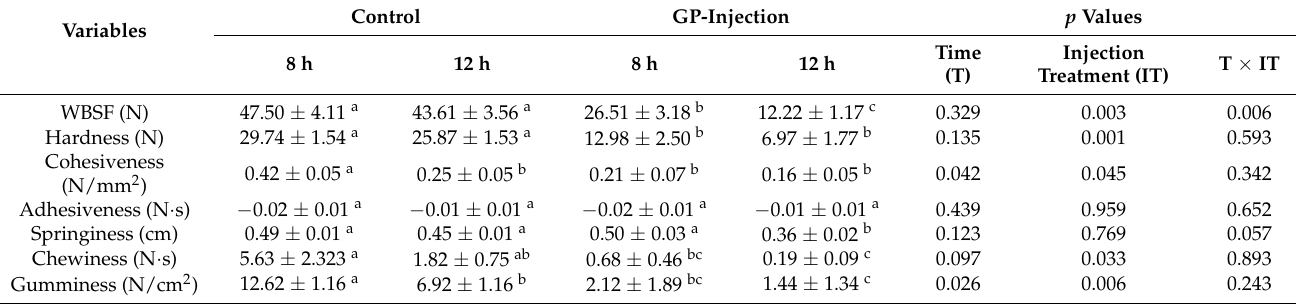
Table 4. Effect of injection treatment (IT; control = without injection; GP injection = ginger powder injection containing zingibain) and cooking time (T; 8 h, 12 h) on Warner-Bratzler shear force (WBSF), and texture profile parameters including hardness, cohesiveness, adhesiveness, springiness, chewiness, and gumminess of M. biceps femoris cooked at 65 °C under sous vide. Values are presented as mean ± SE. Superscripts refer to the significant differences of means ( p < 0.05) within each row. p values for main effects (time and injection treatment) and their interaction are presented in the table.